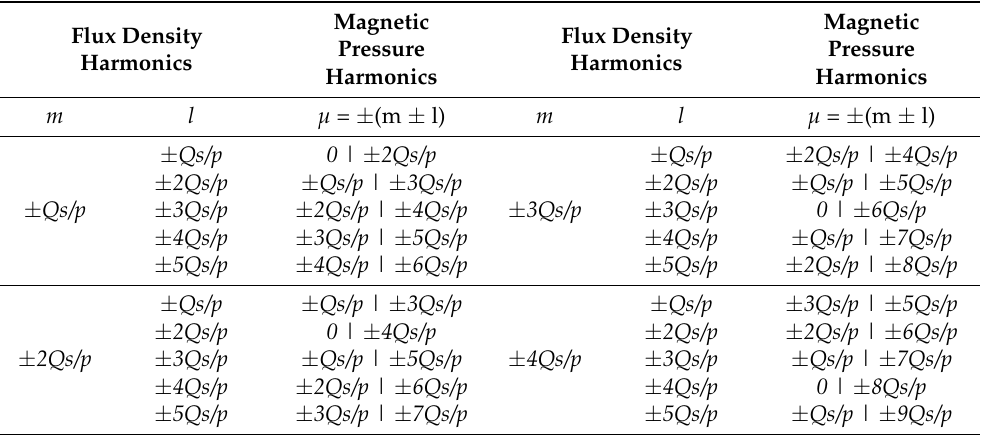
Table 3. Relationship between the harmonics of the flux density and the harmonics of the magnetic pressure on the